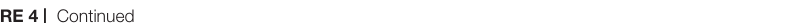
FIGURE 4 | Continued and FUS-P525L neurons. ∗∗ , ∗∗∗ , and ∗∗∗∗ indicate p < 0.01, 0.001, and 0.0001, respectively, according to 2way ANOVA, Tukey post-test for multiple comparisons. Error bars represent SEM. n = 6. (F) HIV-1 vRNA appeared to accumulate in large G3BP1-negative cytoplasmic bodies (arrow heads). (G) HIV-1 and ZIKV vRNA levels following infection of WT and mutated FUS-P525L neurons. ∗∗∗ indicates p < 0.001, according to 2way ANOVA, Tukey post-test for multiple comparisons. Error bars represent SEM. n = 6. MOI indicates multiplicity of infection; SG, stress granule; LL, long linker; MUT, mutant; WT, wild type; vRNA, viral RNA; /,